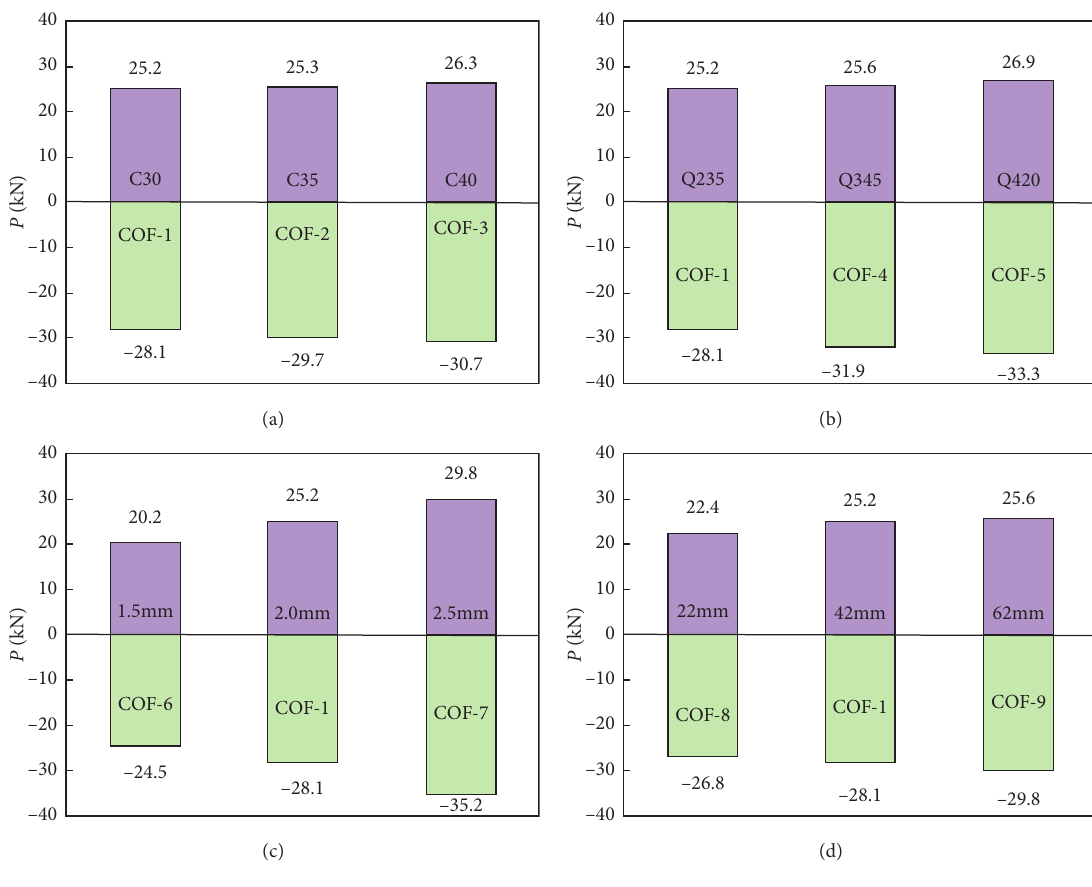
Figure 14: Comparison on bearing capacity of COF system.